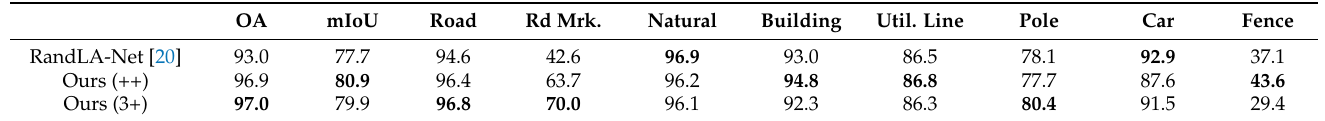
Table 2. Segmentation results evaluated on IoU of each category, mIoU, and OA of the Toronto3D dataset. Note: the bold number represents the highest score in each column. The RandLA-Net network results is from this paper